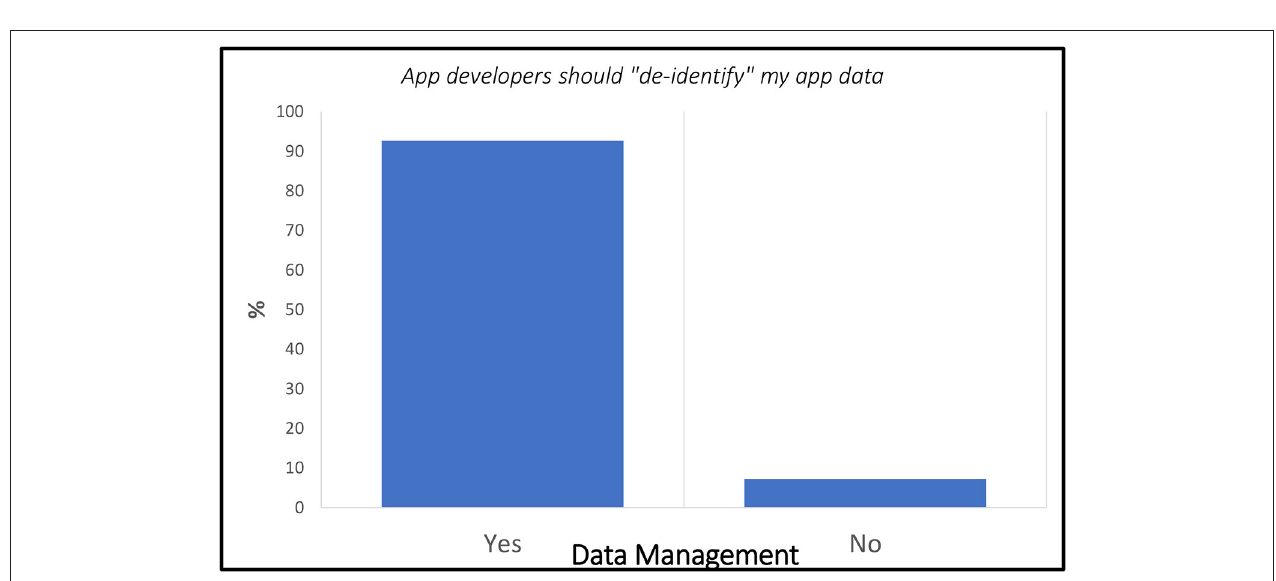
FIGURE 5 | Exit Survey items that aligned with the Data Management